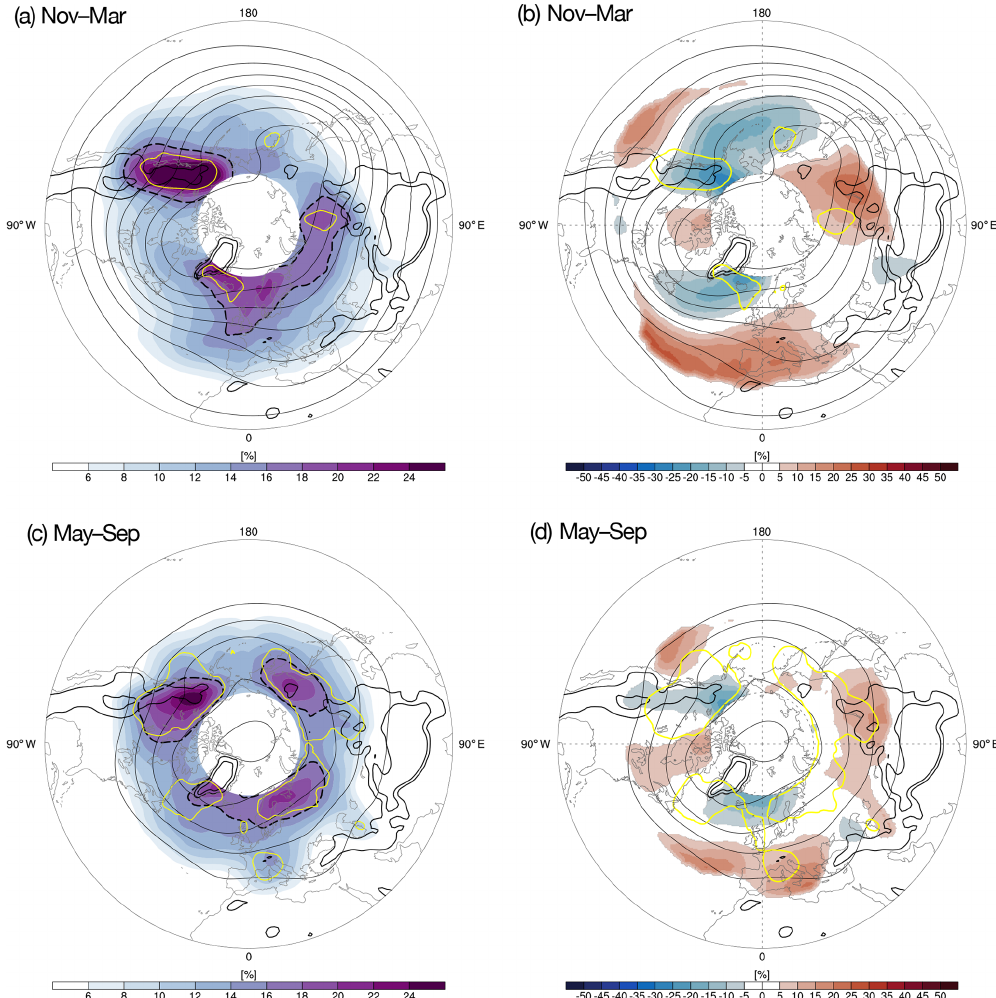
Figure 5. Similar to Fig. 4 but for ridges. The dashed contour indicates the region where the ridge frequency is above the maximum global trough detection frequency ( ≈